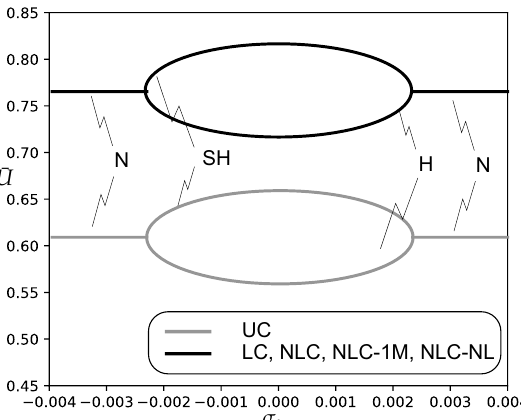
Figure 4. Stability diagram of the trivial solution in the ( σ e , ¯ U ) -plane (N: Neimark bifurcation; H: Hopf bifurcation).